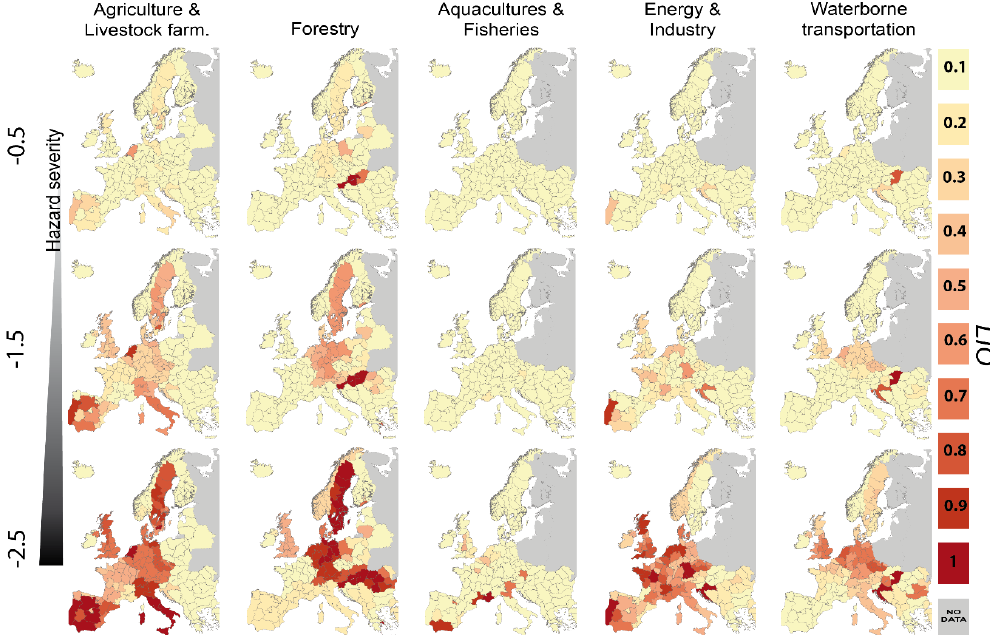
Figure 4. Drought risk maps with the likelihood of impact occurrence (LIO) in the impact categories Agriculture and Livestock Farming, Forestry, Aquaculture and Fisheries, Energy and Industry, and Waterborne transportation (columns) for three hazard levels of SPEI with − 0.5: near normal, − 1.5: severely dry, and − 2.5: extremely dry (rows).